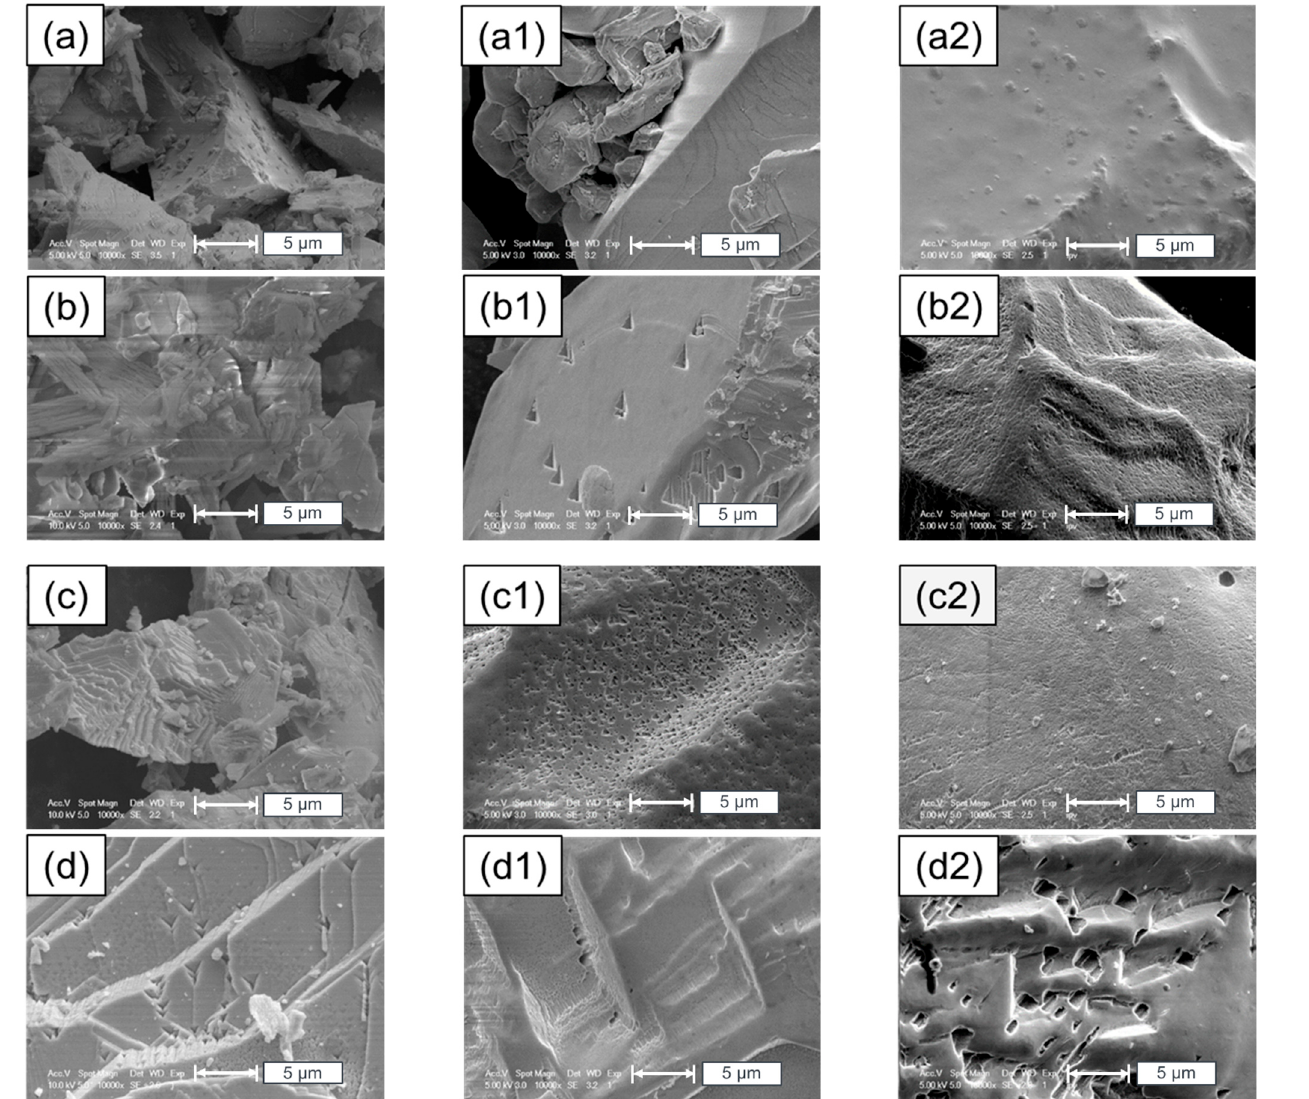
Figure 10. Energy-dispersive X-ray (EDX) spectroscopy data of CdTe 250 powders with differently treated surfaces. The surface treatments change the ratio of Cd to Te at the surface, represented by the relative heights of the peaks. “Activation” in CdCl 2 (green curve) leads to a deposition of Cl and lowers the Te concentration in relation to Cd. In contrast, “etching” (red curve) increases the Te concentration and lowers the Cd concentration. “activation plus etching” (grey curve) also leaves a (relatively) more Te-rich surface when compared to the original surface (blue curve). Clearly, for Te-rich surfaces, the elution of Te is increased (compare Figure 6b). 6. Discussion 6.1. Thermodynamics and Surface Chemistry The experimental data in Figures 3a,b–5a,b do not show any saturation for leaching out Cd and/or Te from the CdTe powders as well as from the milled module pieces. Thus, without any question: CdTe powders and module pieces are not stable in aqueous solu- tions. It is only a matter of time, until the CdTe is completely decomposed. Leaching of Cd and Te out of CdTe-powder strongly depends on the pH of the aqueous solutions. Our results are completely in accordance with earlier data [27,28], which explain the instability of CdTe in aqueous solutions on the basis of thermodynamic considerations: Zeng et al. explained the leaching behavior of CdTe in aqueous solutions with the help of